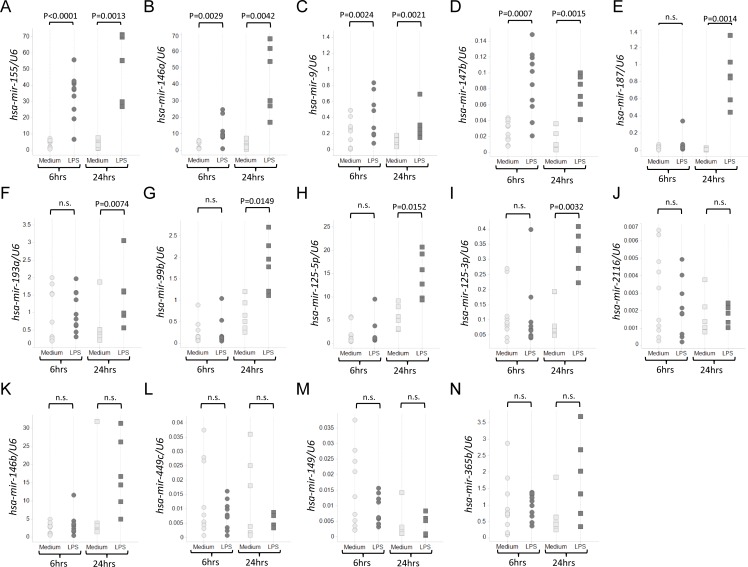
Expression validation of mature miRNAs in LPS-treated monocytes by quantitative RT-PCR.The abundance of signature miRNAs was quantified relative to U6 RNA and shown in black points for the LPS-treated monocytes or gray points for the medium-treated monocytes. Samples from nine healthy donors were tested for the 6-hour timepoint, and six healthy donors were tested for the 24-hour timepoint. Taqman-based qRT-PCR assays to detect mature miRNA expression confirmed statistically significant upregulation of hsa-mir-155 (A), hsa-mir-146a (B), hsa-mir-9 (C) and has-mir-147b (D) at both timepoints. qRT-PCR confirmed statistically significant upregulation of hsa-mir-187 (E), hsa-mir-193a (F), hsa-mir-99b (G), hsa-mir-125-5p, (H), and hsa-mir-125-3p (I) at 24 hours. MiRNA species (J) hsa-mir-2116 (K) hsa-mir-146b, (L) hsa-mir-449c, (M) hsa-mir-149, and (N) hsa-mir-365b were not differentially expressed at either timepoint. P-values were determined using the two-tailed Student’s paired t-test.